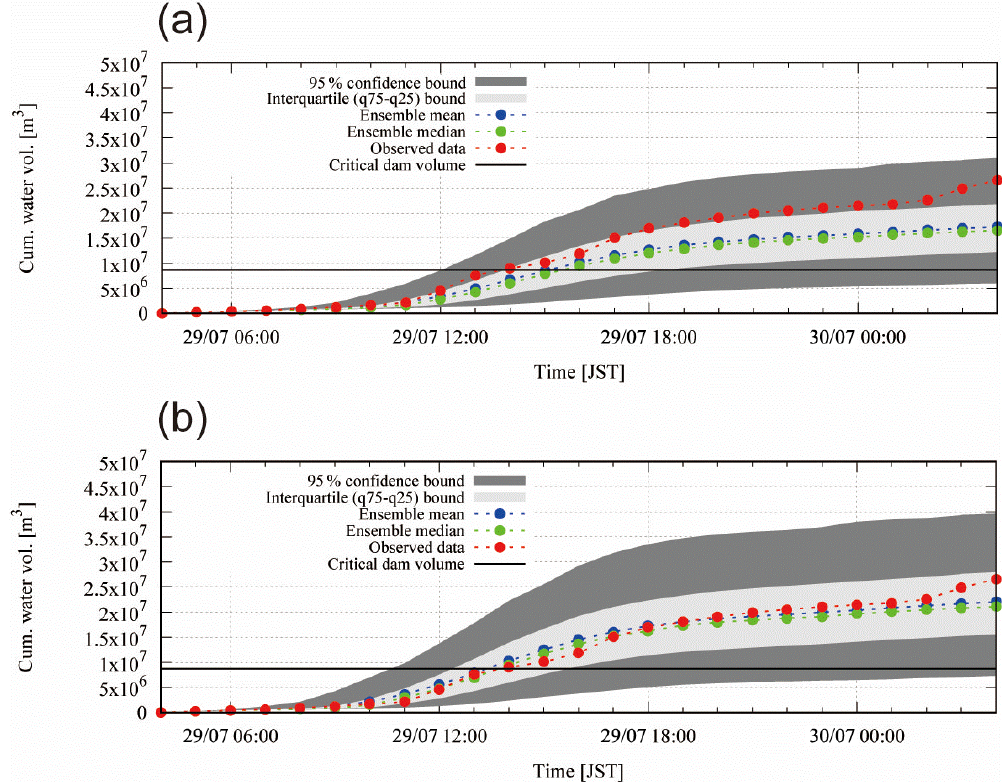
Figure 8. Cumulative dam inflow by the ensemble simulations, mean of simulation and observations, and critical dam volume (a) with parameters by RA and (b) with parameters by RC.